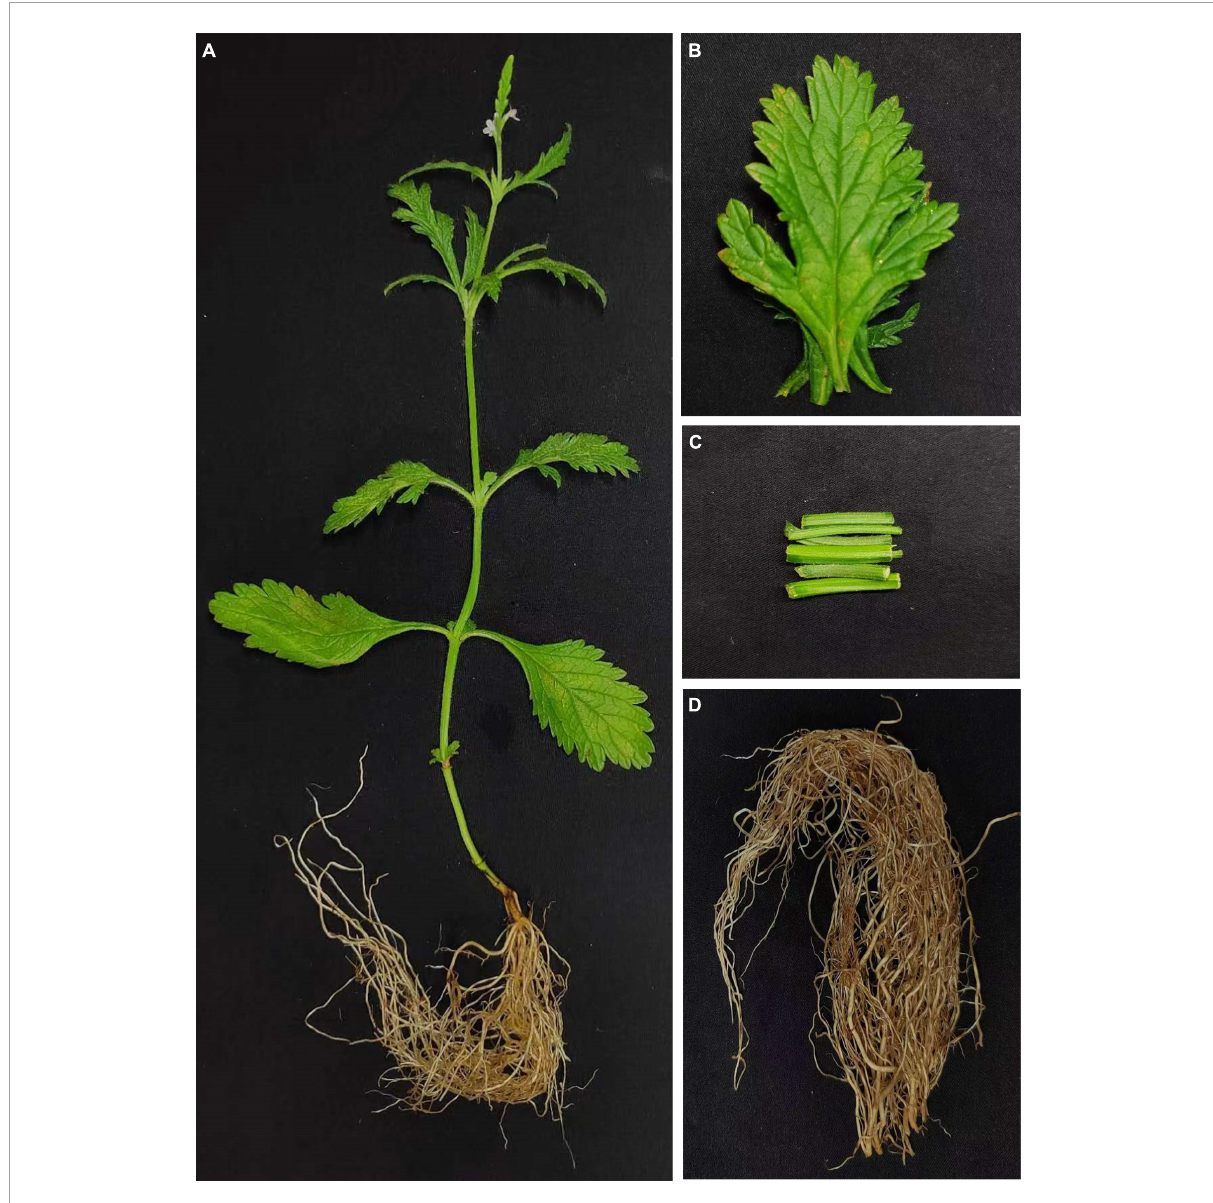
FIGURE1 Plant and tissues of Verbena officinalis . (A) Whole V. officinalis . plant. (B) Leaves. (C) Stems. (D)